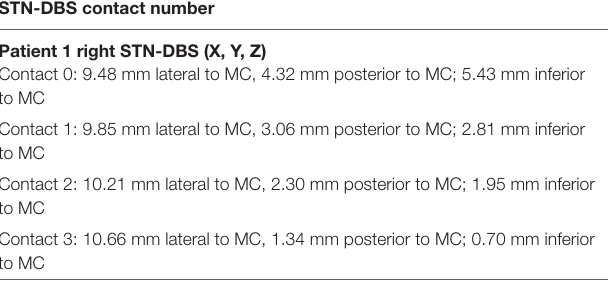
taBLe 1 | Post-operative STN-DBS